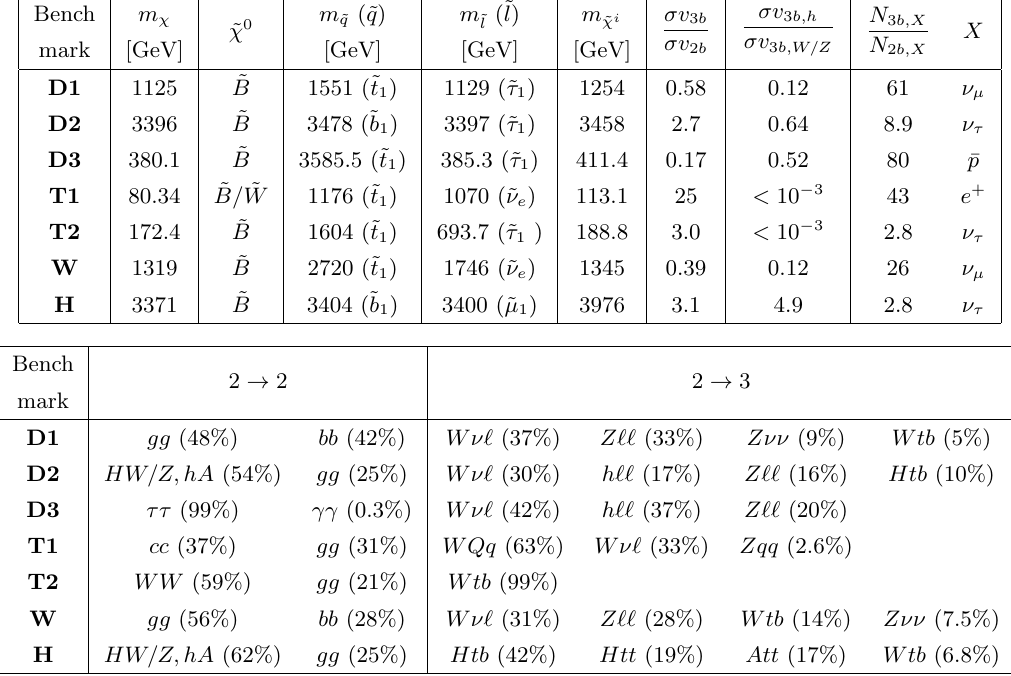
Table 7 . Characteristic properties of the benchmark models de(cid:12)ned in table 6. The upper table shows neutralino mass and composition ( ~ B = Bino-like, ~ B= ~ W = mixed Bino/Wino), identity